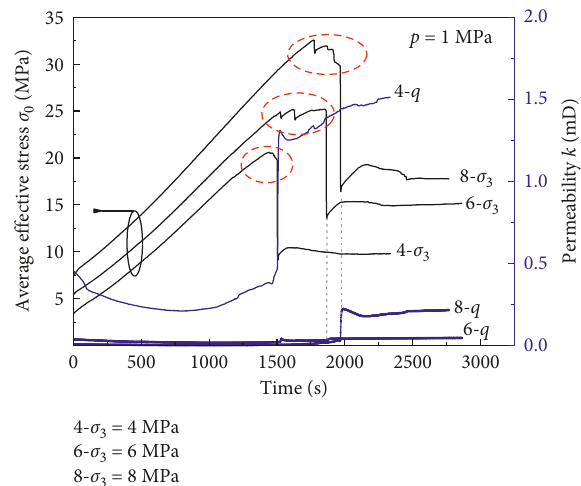
Figure 7: Time dependences of average effective stress and